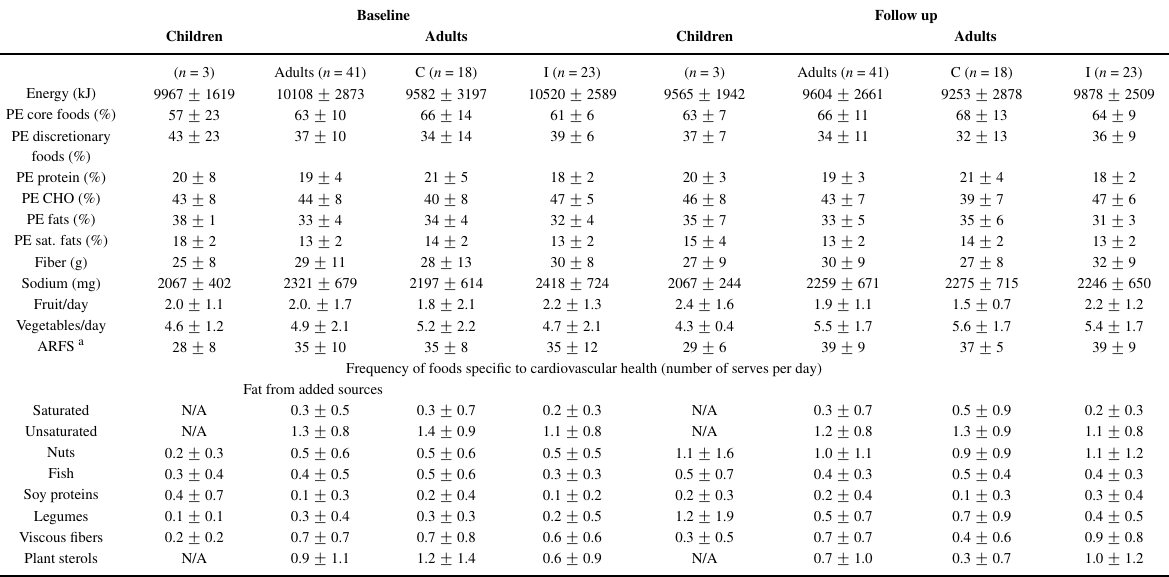
Abbreviations: C—Control group; I—Intervention group; N/A—Not assessed; PE—Percentage energy; ARFS—Australian Recommended Food Score; a measure of dietary